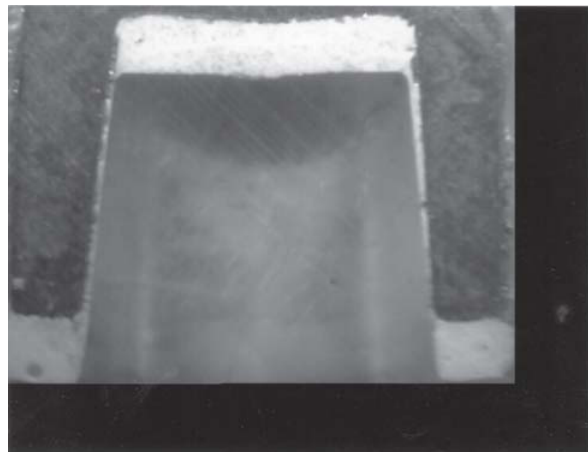
Figure 5- 515ºC/75% group